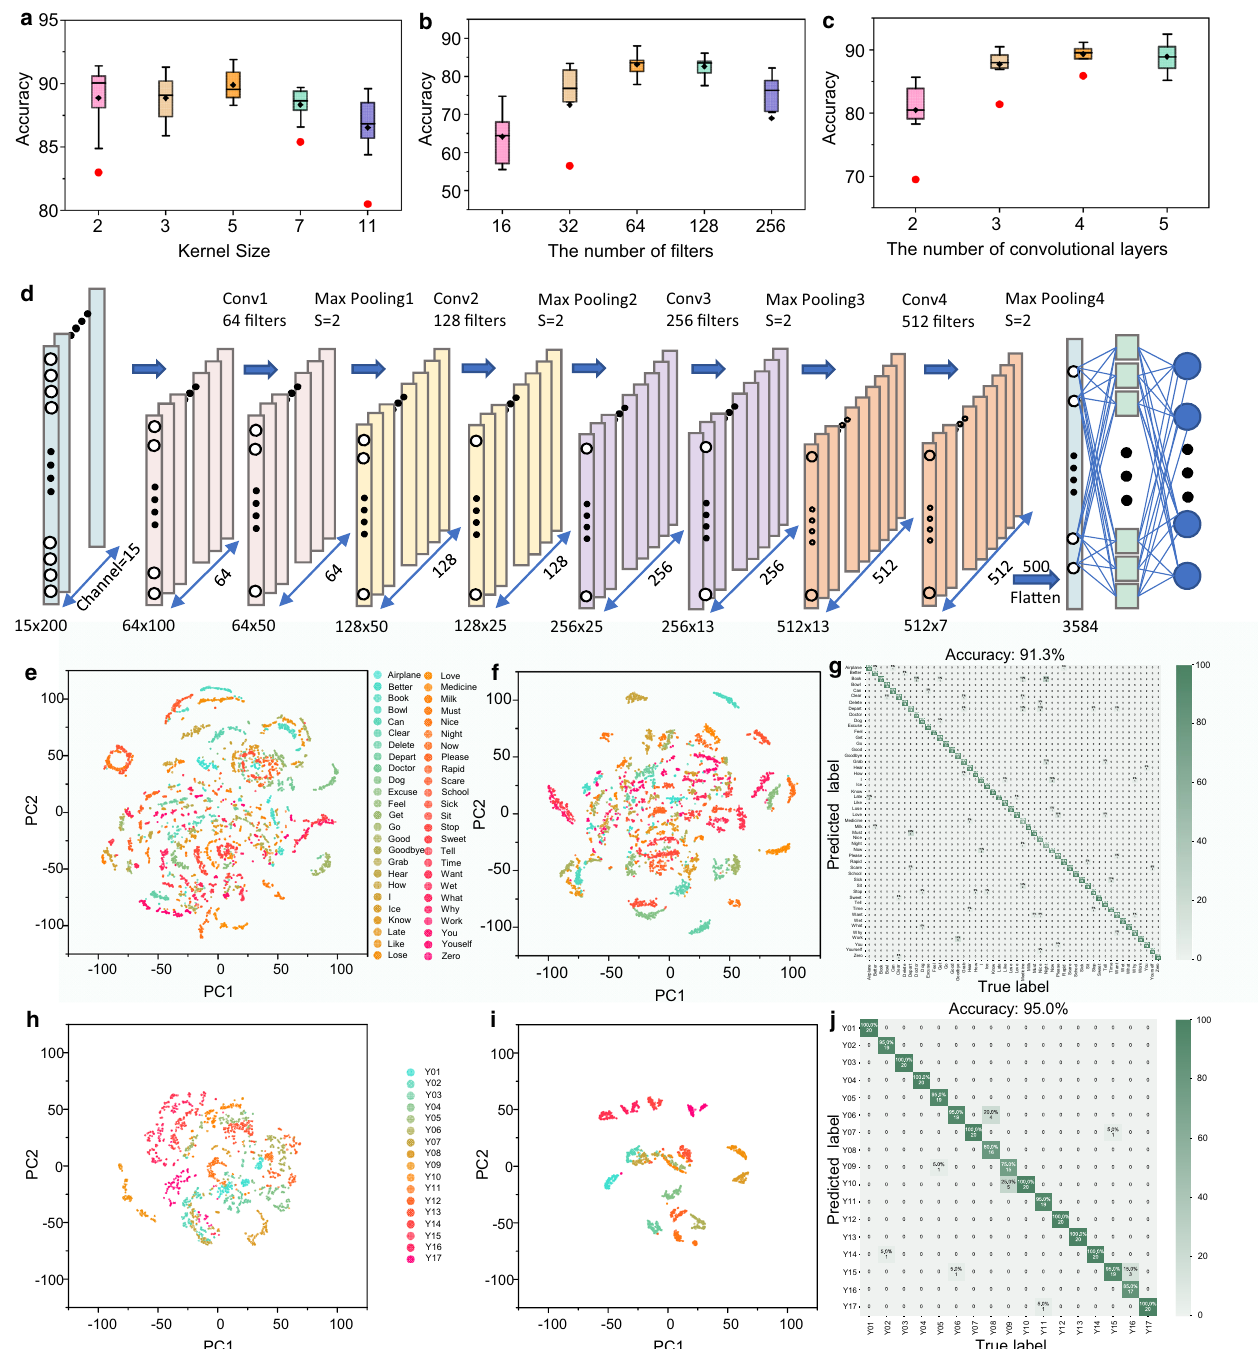
Fig. 3 Word and sentence recognition based on the nonsegmentation method. a – c Optimization of CNN structure parameters based on accuracy performance, including Kernel size, the number of fi lters, and the number of convolutional layers. Boxplots indicate median (middle line), 25th, 75th percentile (box) and 5th and 95th percentile (whiskers) as well as outliers (single points). d Final structure of CNN after optimization. e – f Cluster results of word signal from CNN input layer and output layer. g Confusion map of recognizing 50 words. h – i Cluster results of sentence signal from CNN input layer and output layer. j Confusion map of recognizing 17 sentences. Source data 65 of Figs. 3g, j are provided in Harvard